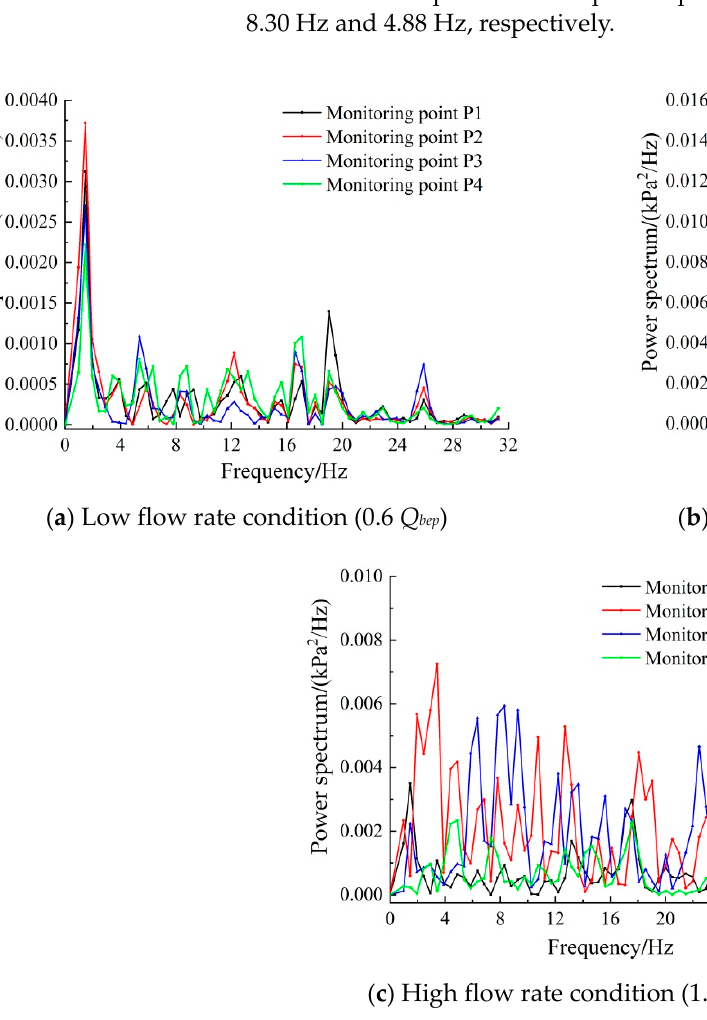
Figure 17. Power spectrum of each monitoring point in sub-band 0~31.25 Hz under different working conditions.